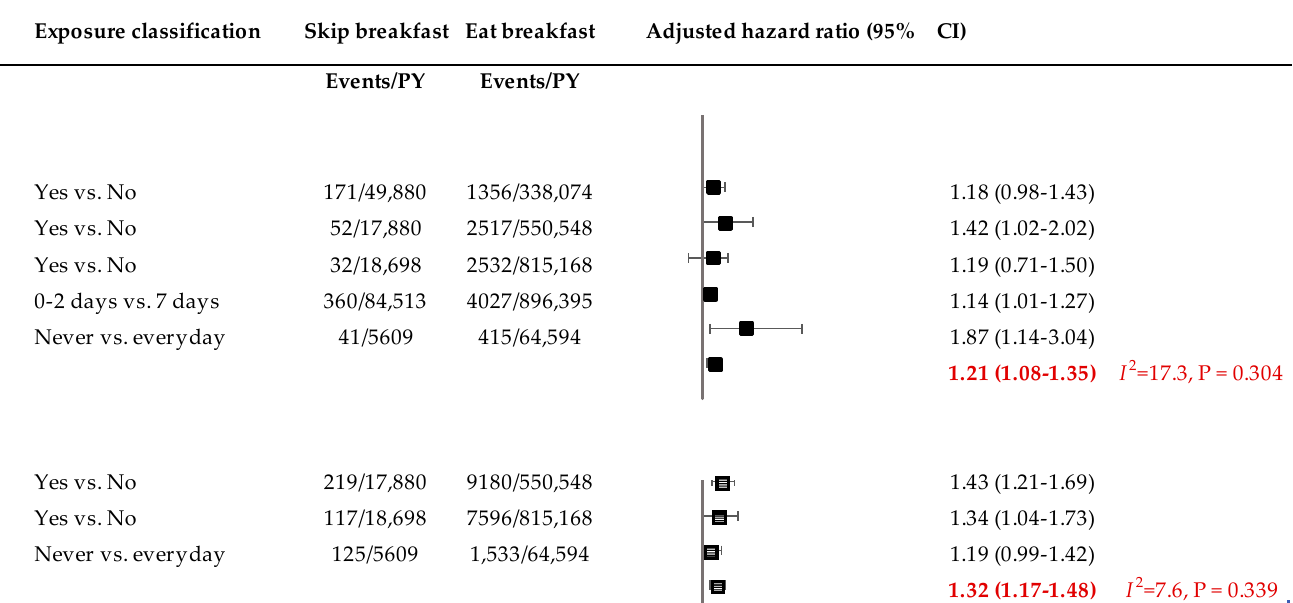
Figure 2. Forest plot of the association between breakfast skipping and cardiovascular disease morbidity and mortality and all-cause death. Covariates adjusted for in individual studies: * In addition to age, diet, demographic, and activity factors, this model was further adjusted for the body mass index (BMI) updated every 2 years (<18.5, 18.5–24.9, 25–29.9, ≥ 30 kg/m 2 , missing) as well as diabetes mellitus (yes/no), hypertension (yes/no), and hypercholesterolemia (yes/no), also updated every 2 years. + Adjusted for age and history of hypertension, history of diabetes mellitus, body mass index, smoking status, alcohol status, education level, physical activity, walking duration, sleep duration, marital status, and work schedule. β Adjusted for age, sex, ethanol, energy, and intake of vegetables, fruits, fish, soy, milk/dairy products, nuts, saturated fatty acid, dietary fiber, and sodium, as well as smoking status, leisure-time sports, sleep duration, perceived mental stress, living alone, physical labor, and public health center area. δ All models were adjusted for age, sex, race/ethnicity, marital status, family income level, smoking status,